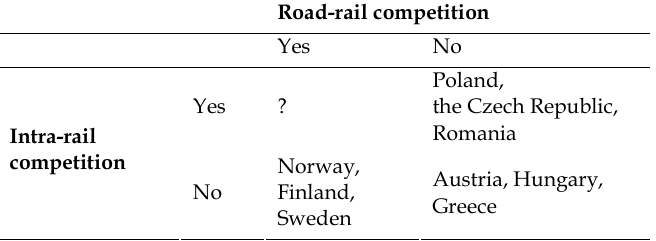
Table 2. Occurrence of intra-modal and inter-modal competition in the countries